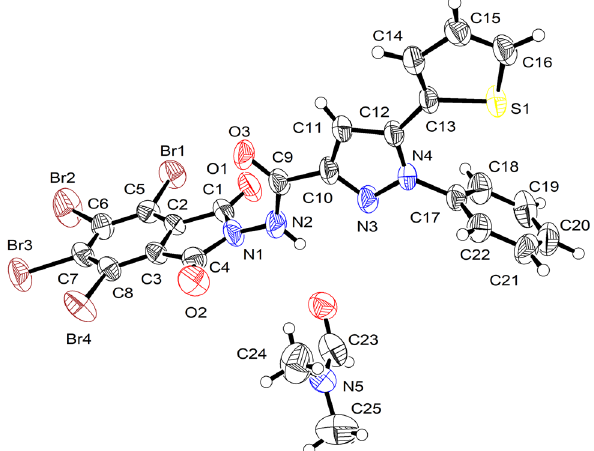
Table  : Data collection and